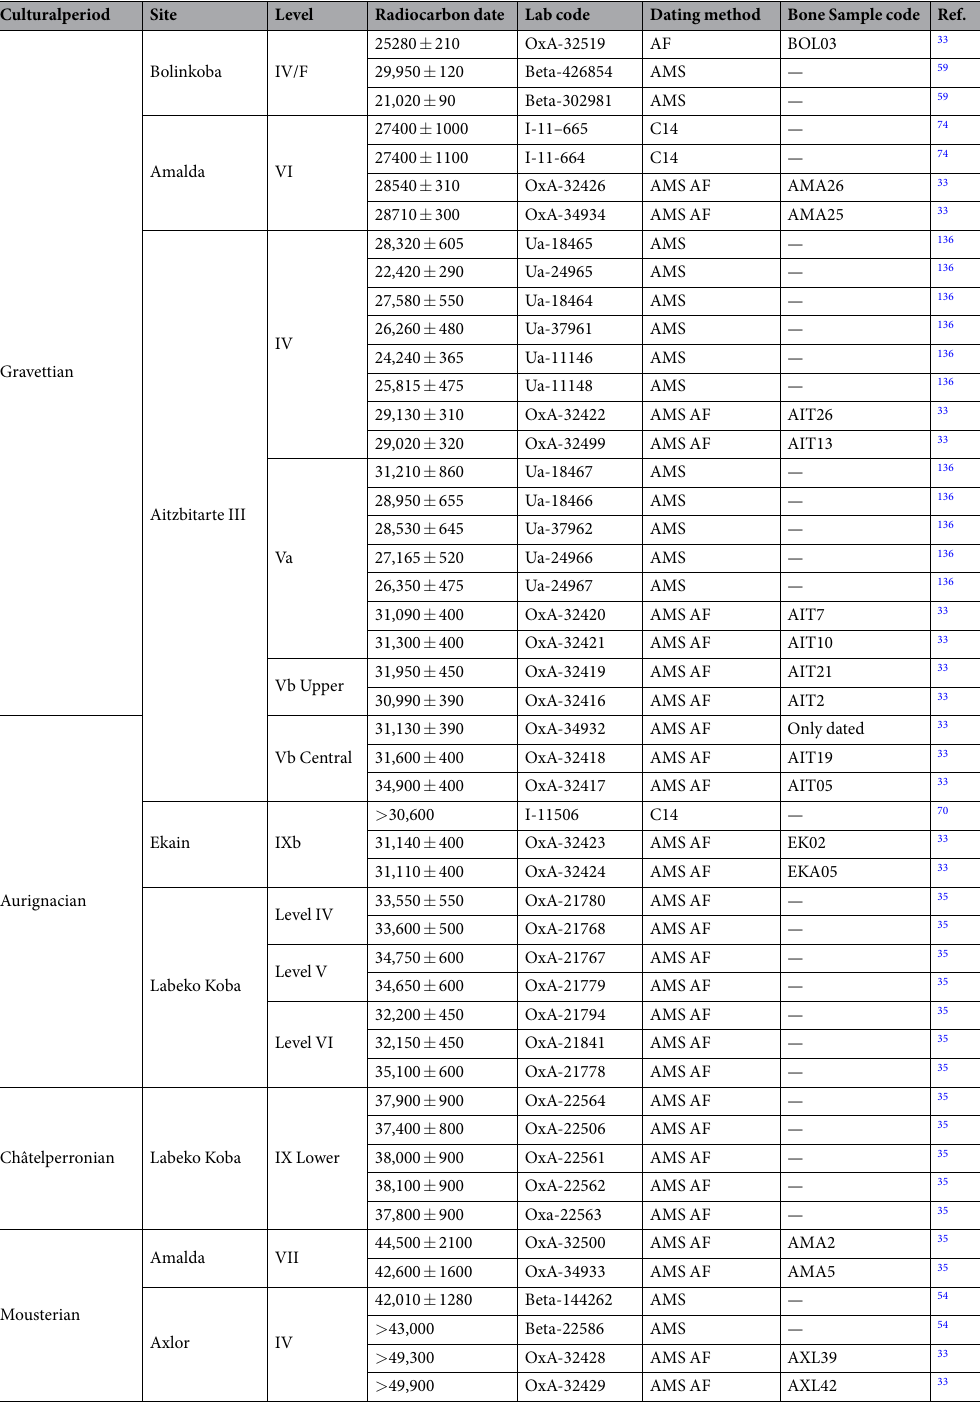
Table 2. Radiocarbon dates from sites and levels sampled, with laboratory codes and sample preparation methods used. AF: collagen extracted using the ultrafiltration method prior to analysis. Bone sample code is included for bones, that were both dated and analysed for stable